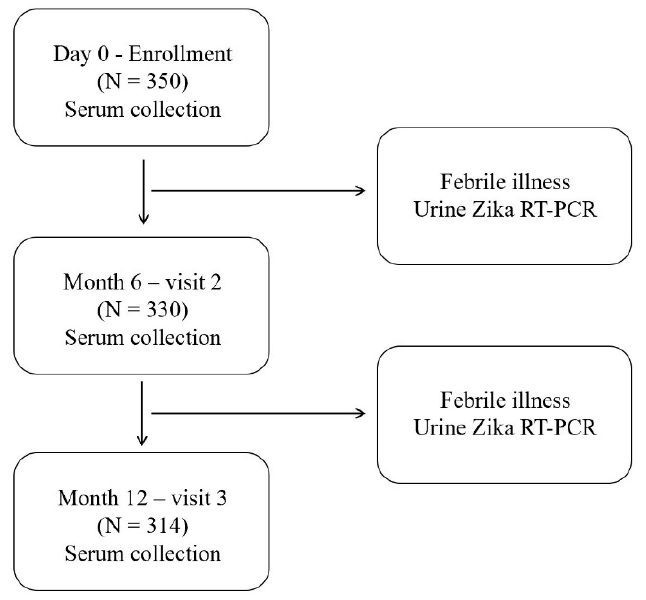
Figure 2. Schematic diagram of the study design and procedures. Zika virus (ZIKV) and dengue virus nonstructural protein 1 antibodies were examined at enrollment (Day 0) and after 6 and 12 months. Urine ZIKV RT-PCR was performed for volunteers who visited a hospital with acute febrile illness.